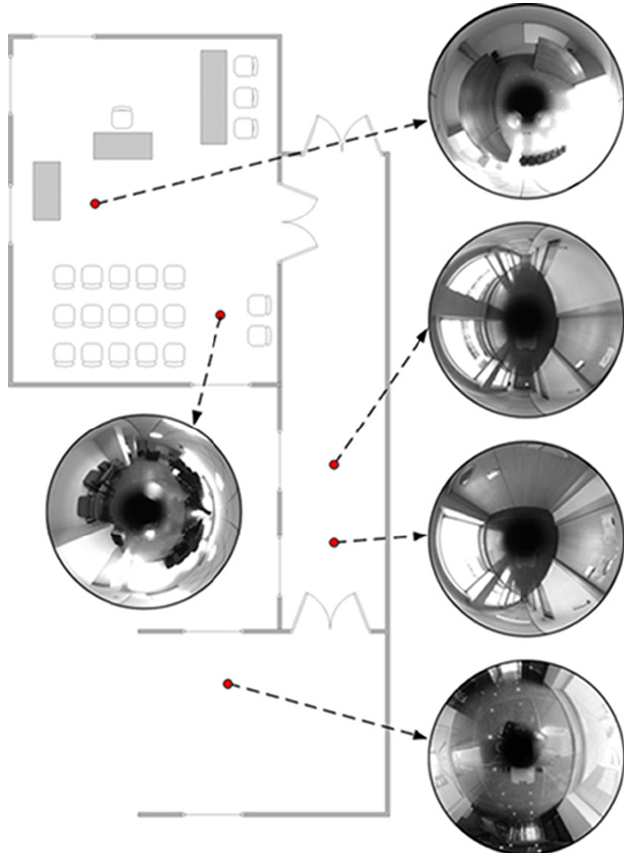
Figure 21. Mockup for Dataset 3. Five views of the environment are